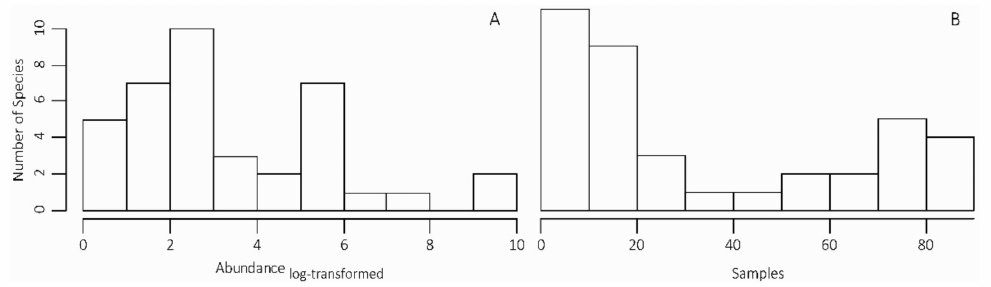
Figure 3. Histograms of ( A ) log-transformed species abundance and ( B ) frequency of species occur- rences in high-frequency samples from the San Marcos Artesian